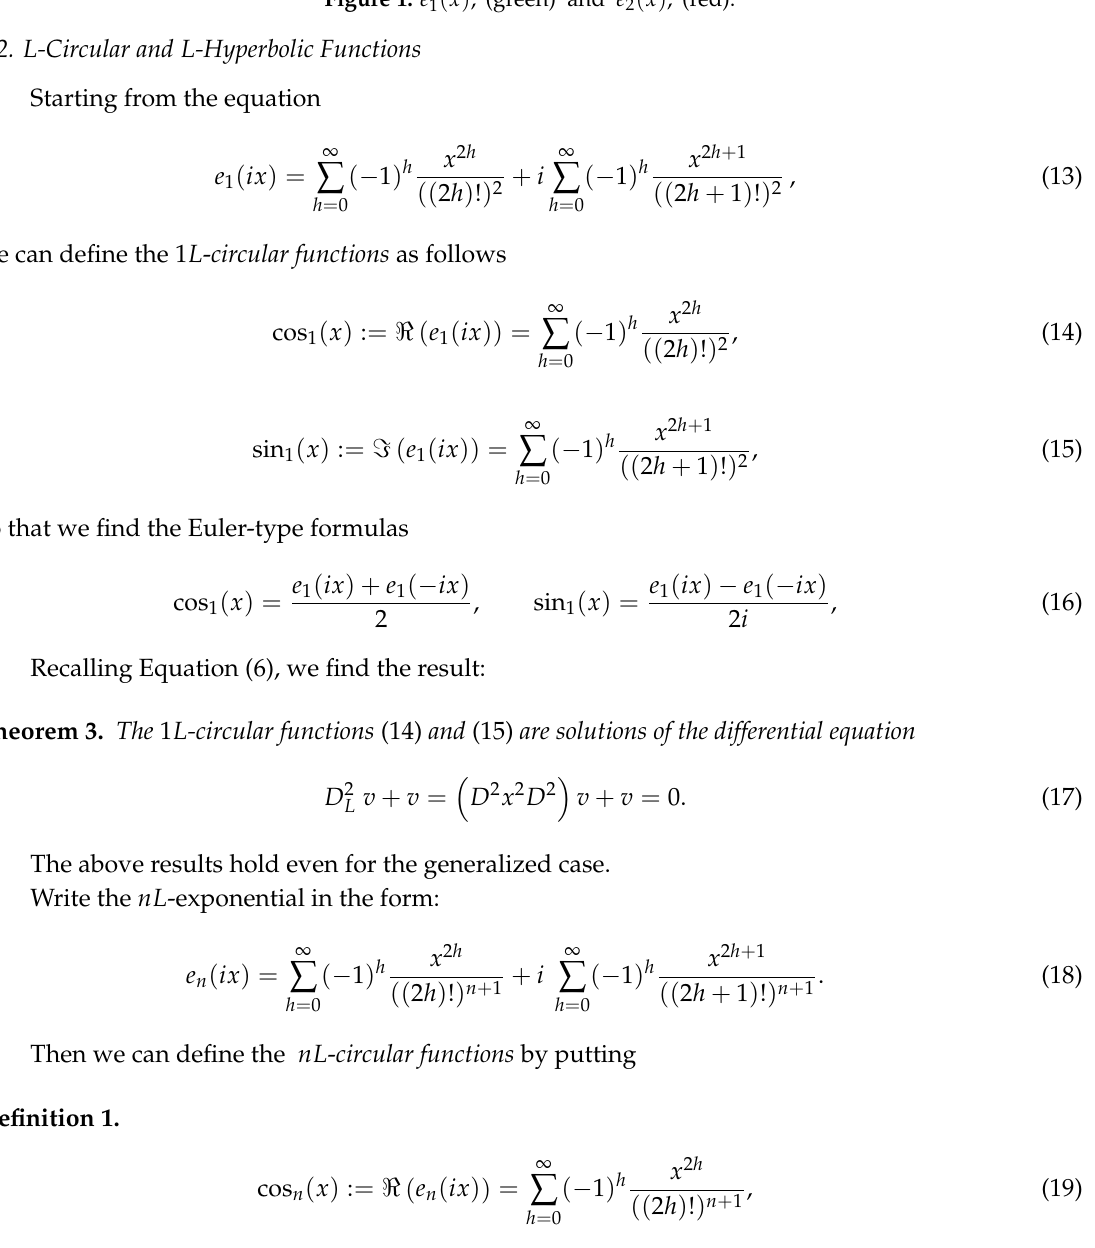
Figure 1. e 1 ( x ) , (green) and e 2 ( x ) ,